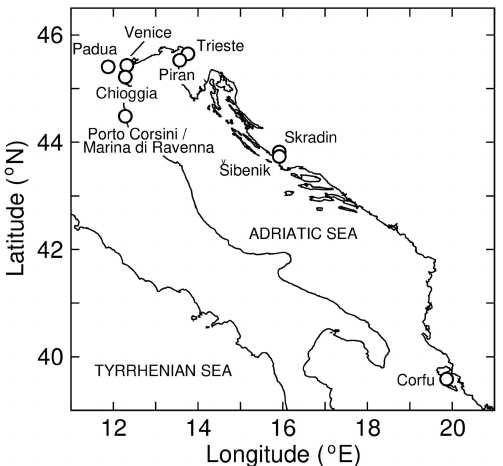
Figure 1. The geographic area of interest; the locations cited in the text are